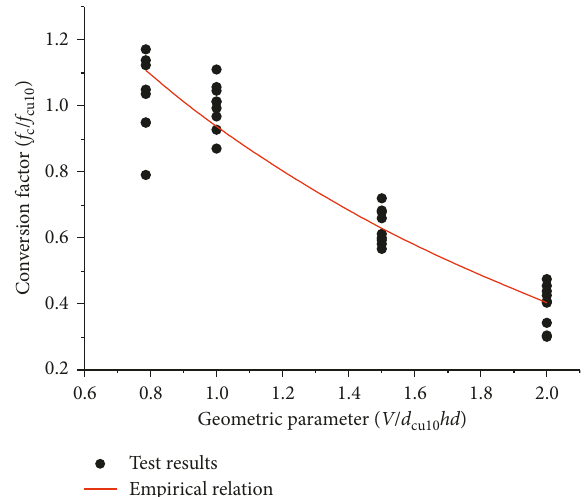
Figure 9: Empirical relation of conversion factors for compressive strength.